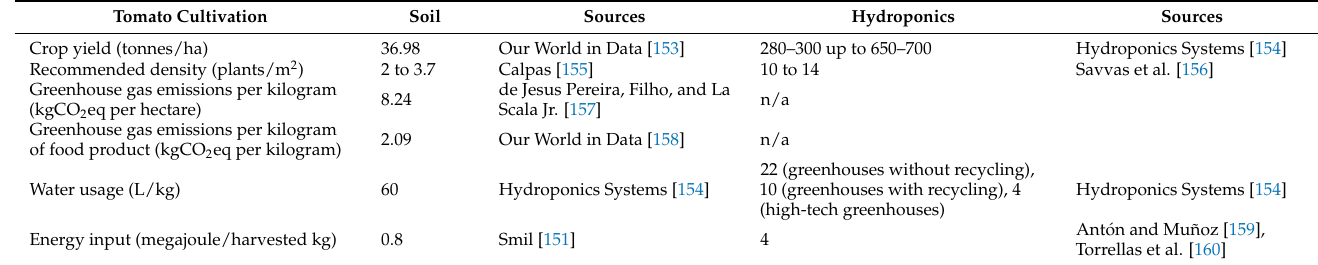
Table 7. Hydroponic and soil tomato cultivation case